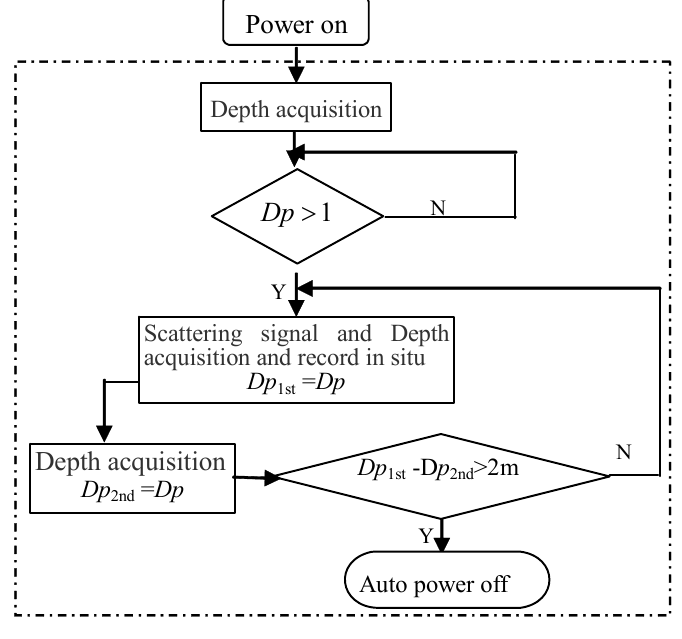
Figure 6. Flow diagram of the automatically control processing under